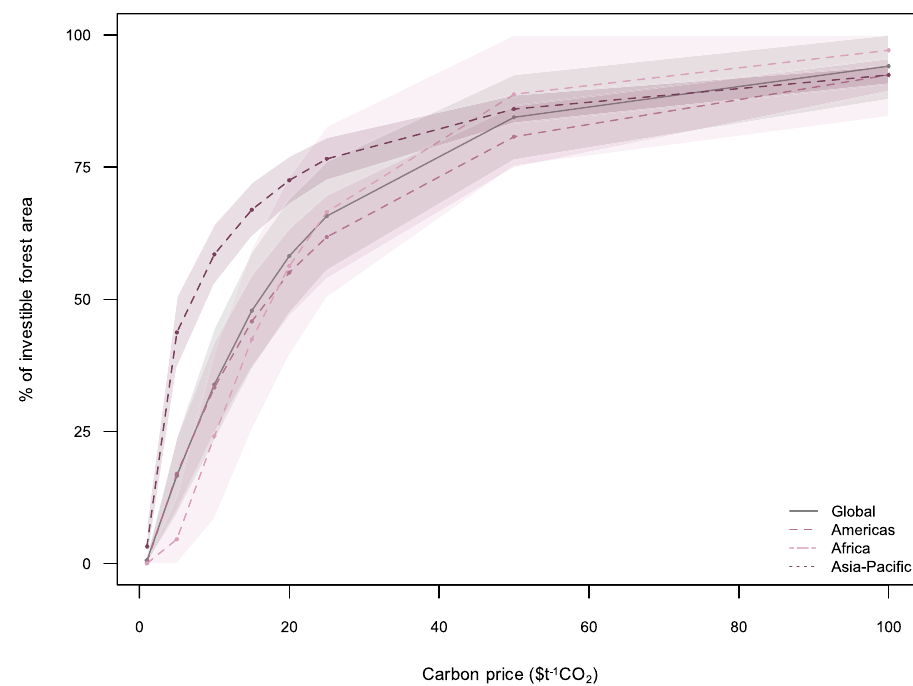
Fig. 3 Effect of carbon pricing on the fi nancial viability of forest carbon sites. Graph indicates the proportion of investible forest carbon that are fi nancially viable for carbon fi nance. Shadings around the lines represent con fi dence bands based on standard